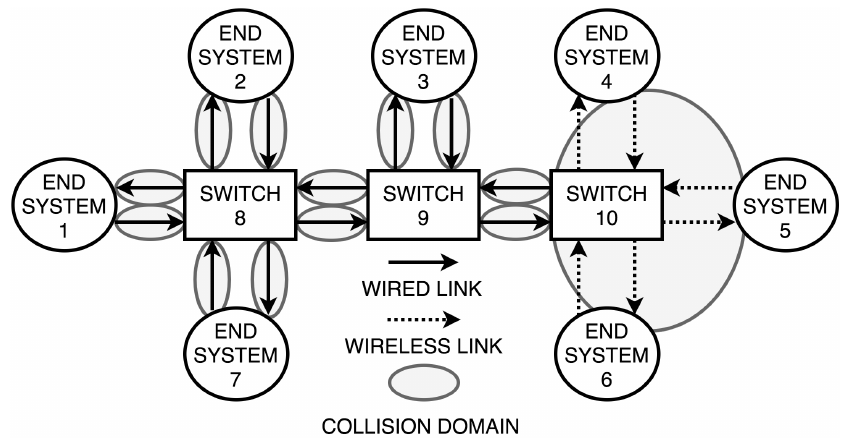
Figure 1. Example of hybrid multi-hop